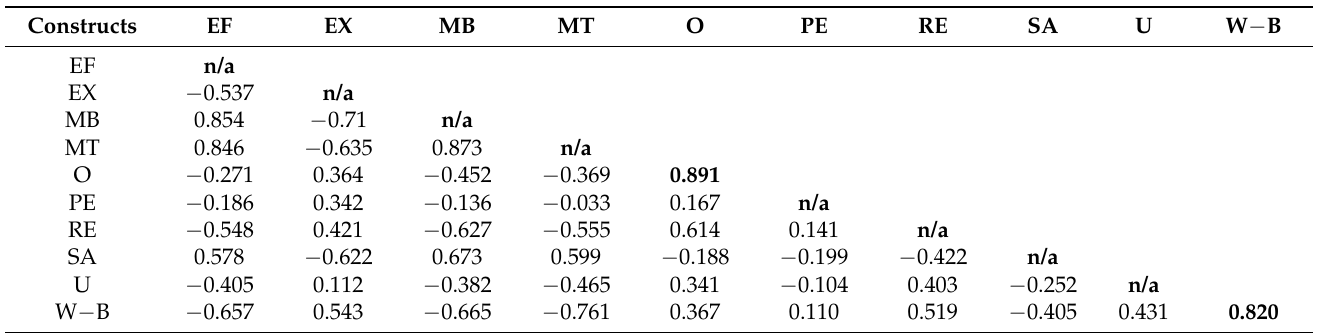
Table 4. Fornell and Larcker criterion